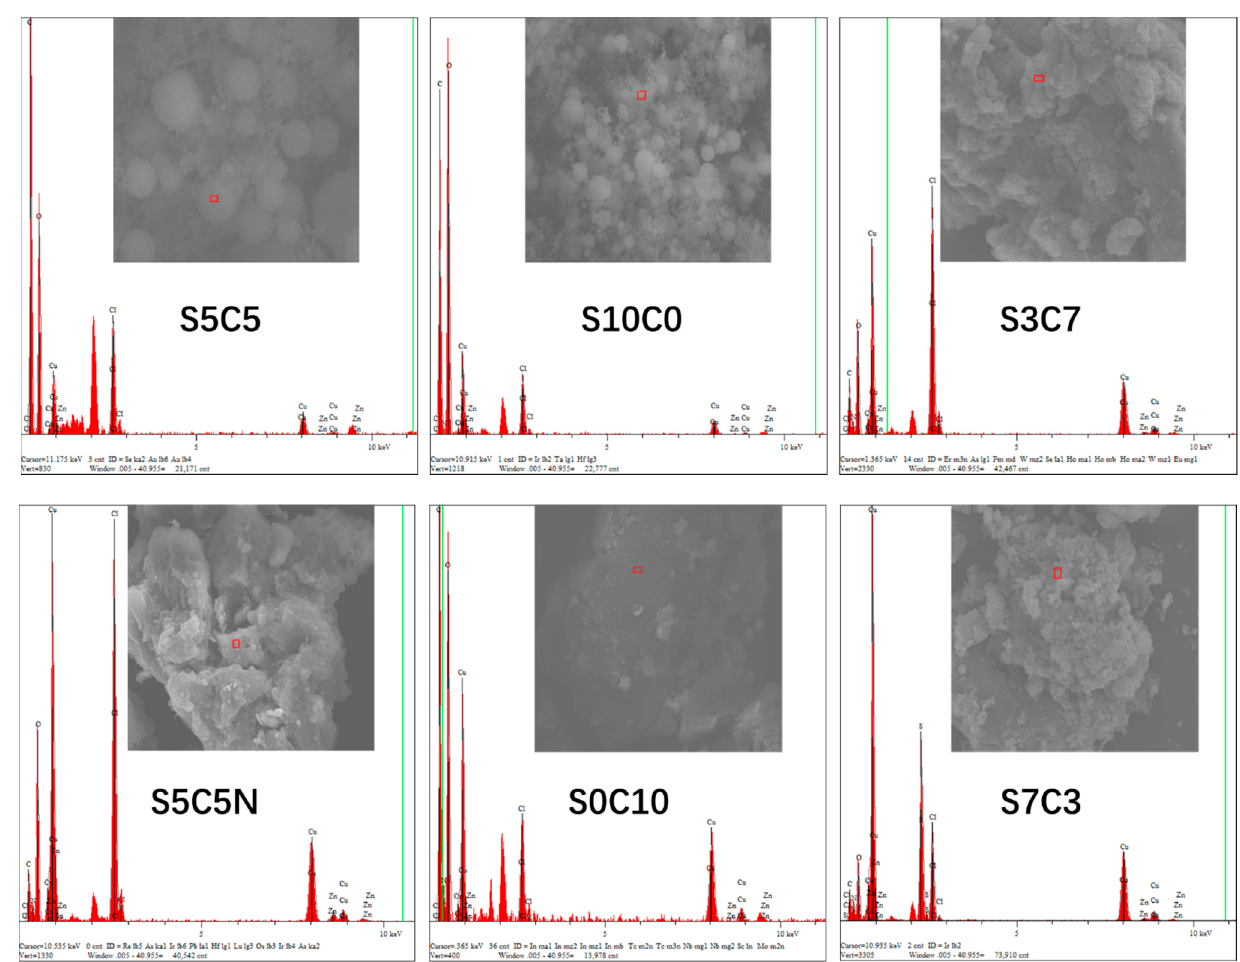
Figure 1. EDX images of the hydrochars. Table 1. The yields, specific surface area, average pore diameter, and elemental composition of the synthesized hydro- chars.